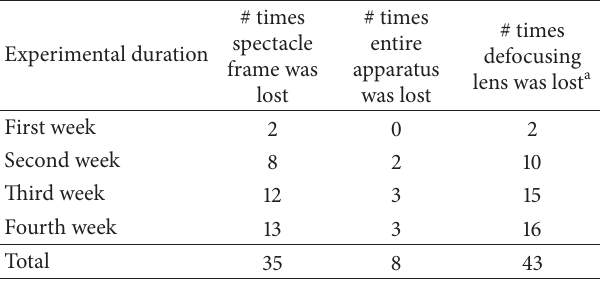
Table 1: Stability assessment of the head-mounted spectacle frame apparatus.